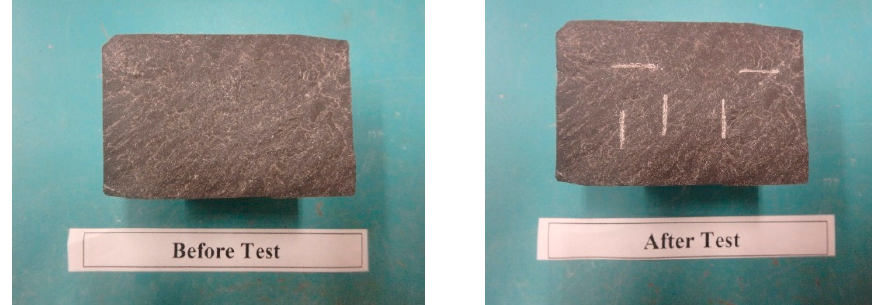
Figure 5. Example of rock surface conditions with rough surface (left over from BTS test) used for CAI test .